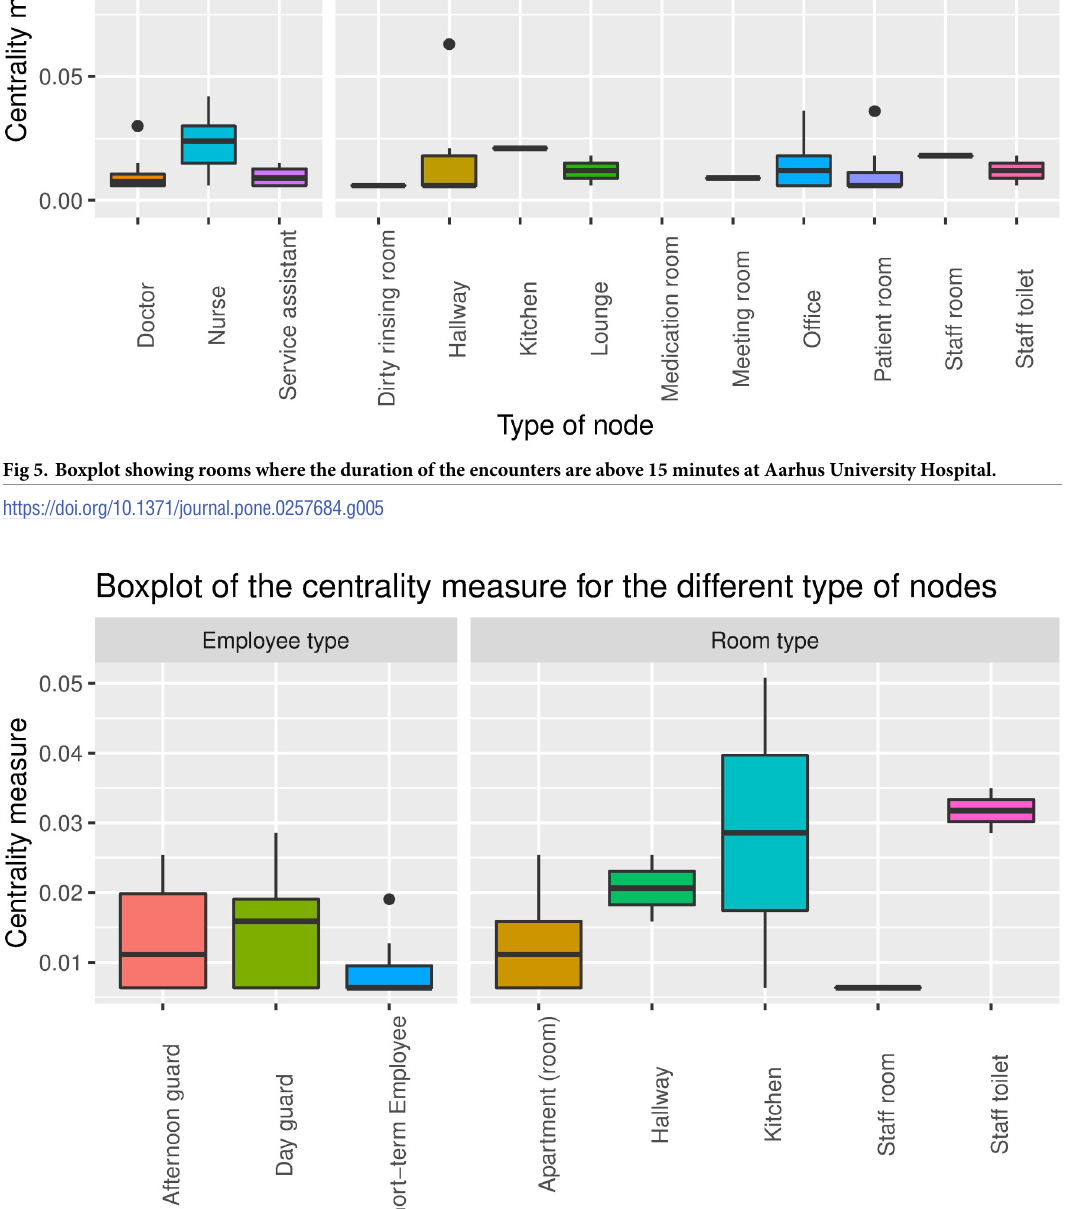
PLOS ONE | https://doi.org/10.1371/journal.pone.0257684 September 20,